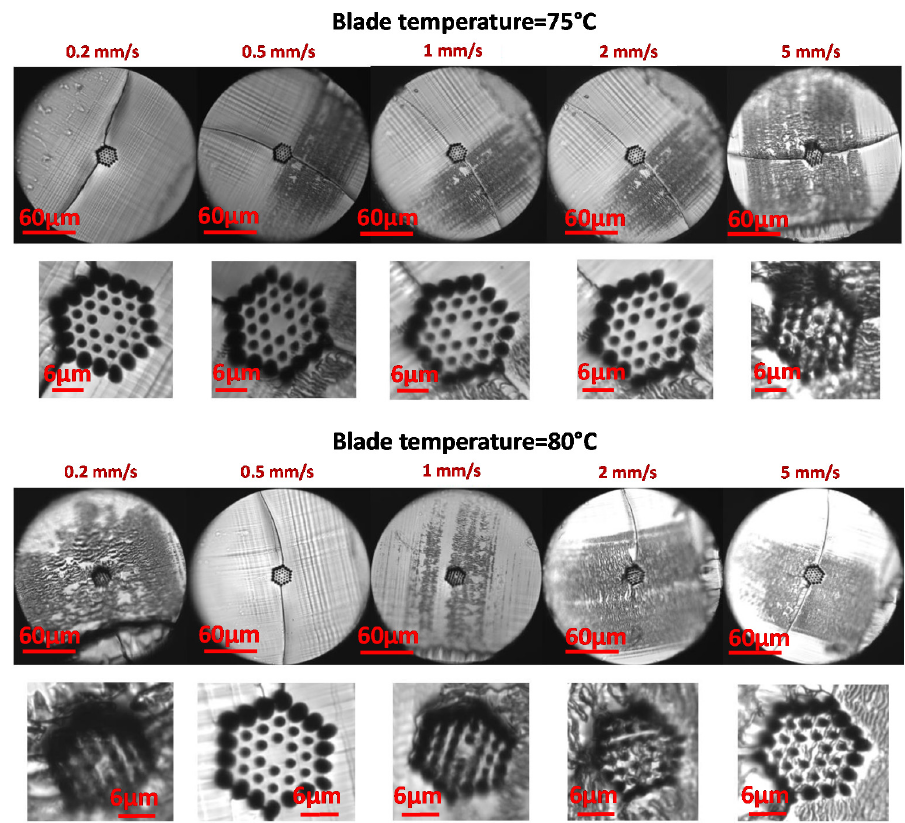
Figure 6. 3-ring mPOF end faces at different blade temperatures and blade cutting speeds.